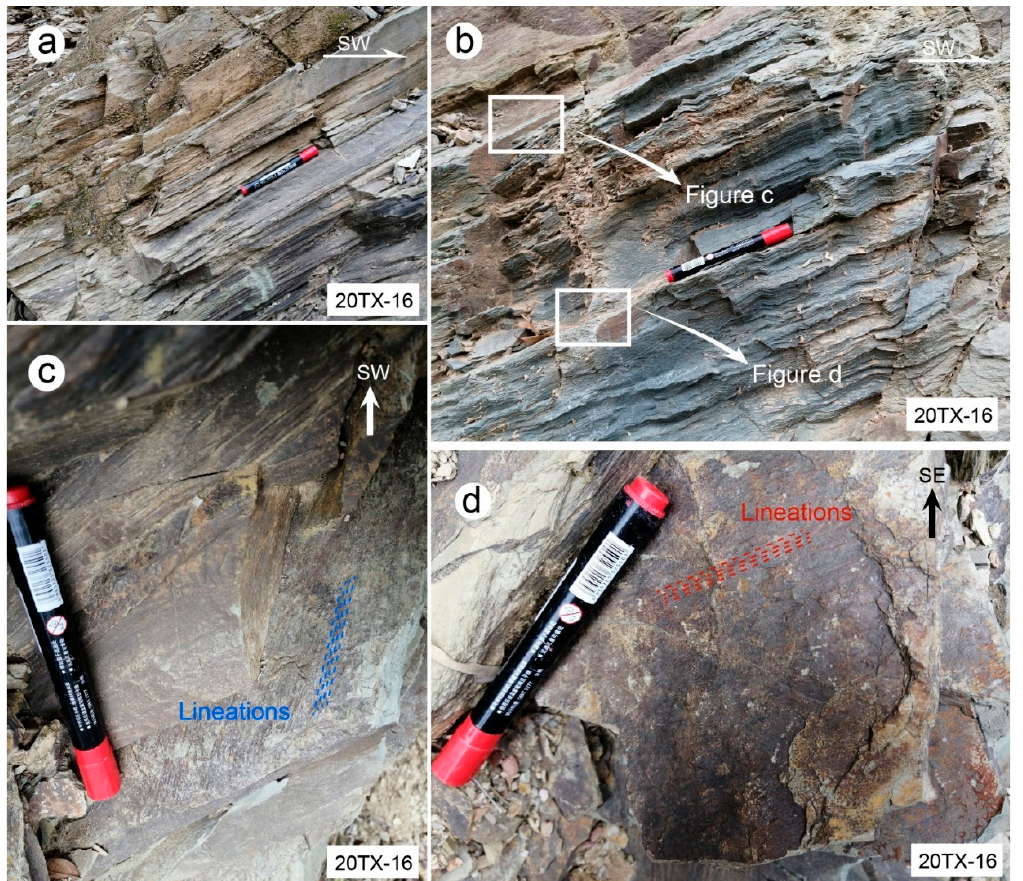
Figure 4. Outcrop photographs of structures in the NE domain of the Taoxi dome. ( a ) Felsic schist with NE-dipping foliations. ( b ) Undulating foliations developed in the felsic schist with two groups of stretching lineation. ( c ) One group of stretching lineation are downdip, photographed from above. ( d ) Another group of stretching lineation are foliation-parallel sub-horizontal, photographed from above.